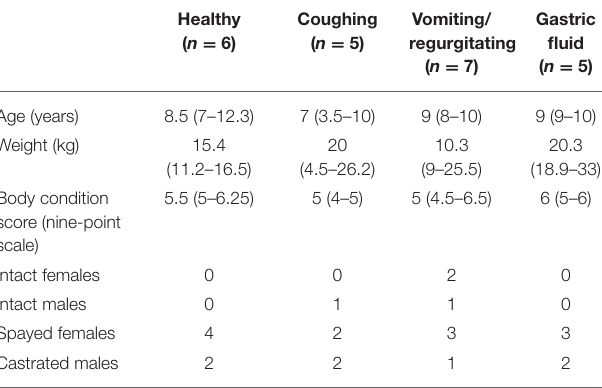
TABLE 1 | Demographic data (age, weight, body condition score, sex and reproductive status) for each group are displayed as median